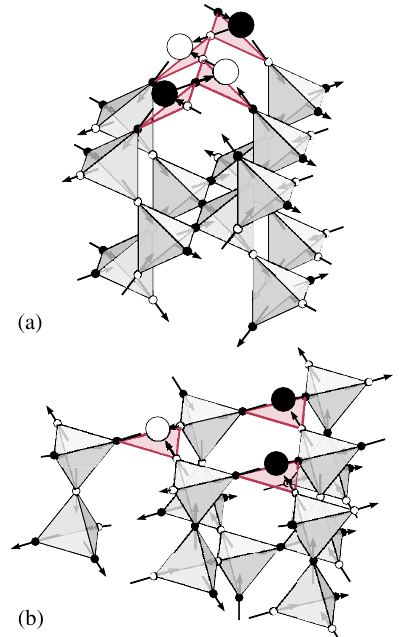
FIG. 9. Representative ground states of films cleaved along the (a) [110] or (b) [111] direction. In both cases, the cleaving shown cuts one spin per surface tetrahedron, leaving orphan triangles at the surface. Flux lines are therefore required to have end points on each of these orphan triangles, leading to surface charges =J irrespective of the sign of J O